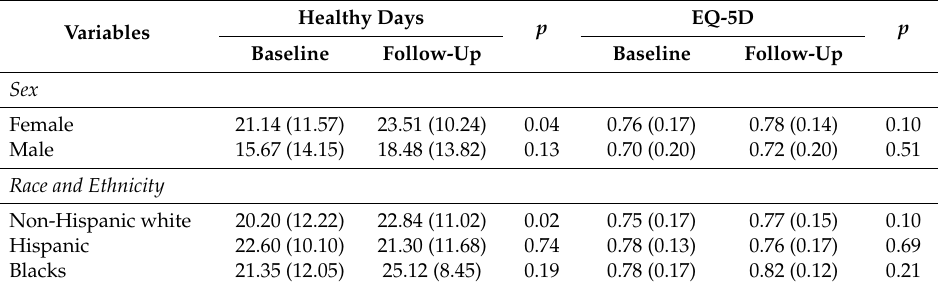
Table 3. HRQOL measures by socio-demographic characteristics.